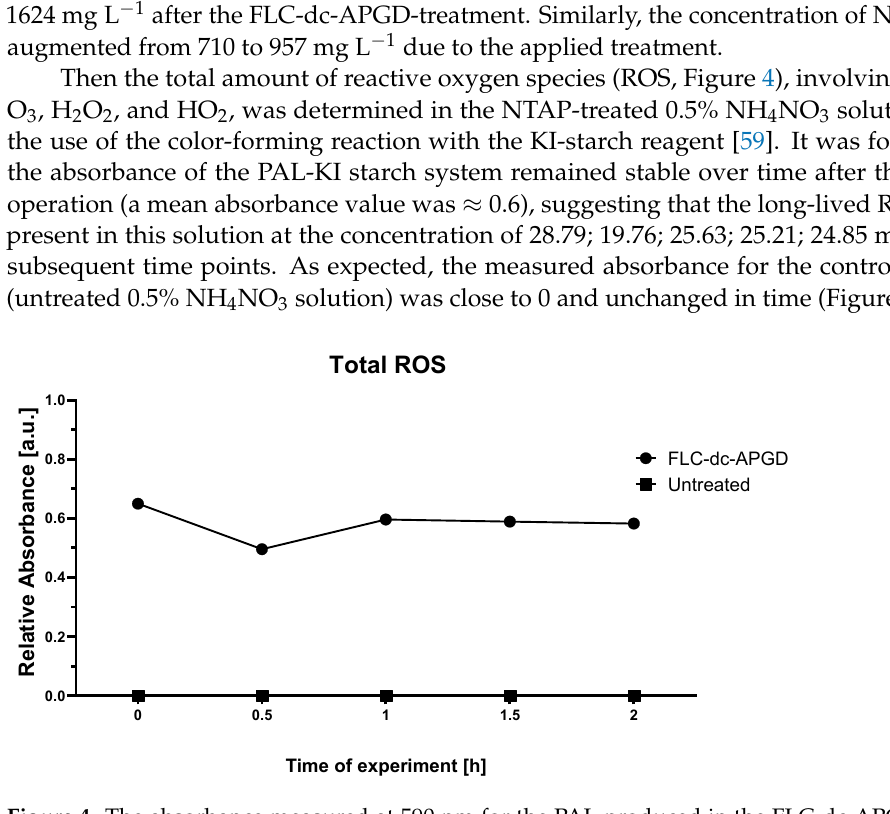
Figure 4. The absorbance measured at 590 nm for the PAL produced in the FLC-dc-APGD-based reaction-discharge system and the untreated 0.5% NH 4 NO 3 solution.